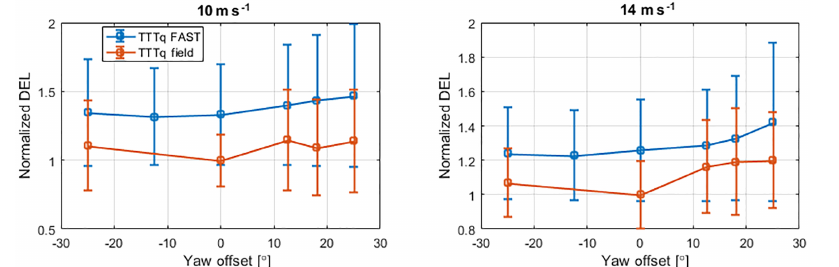
Figure A6. Comparison between predicted (FAST) and measured (field) TTTq DELs.